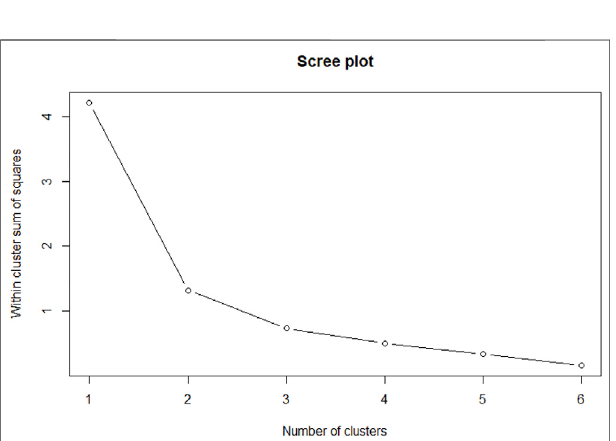
FIGURE 6 | Scree plot for the k-means cluster analysis of the 43 AR use-cases.